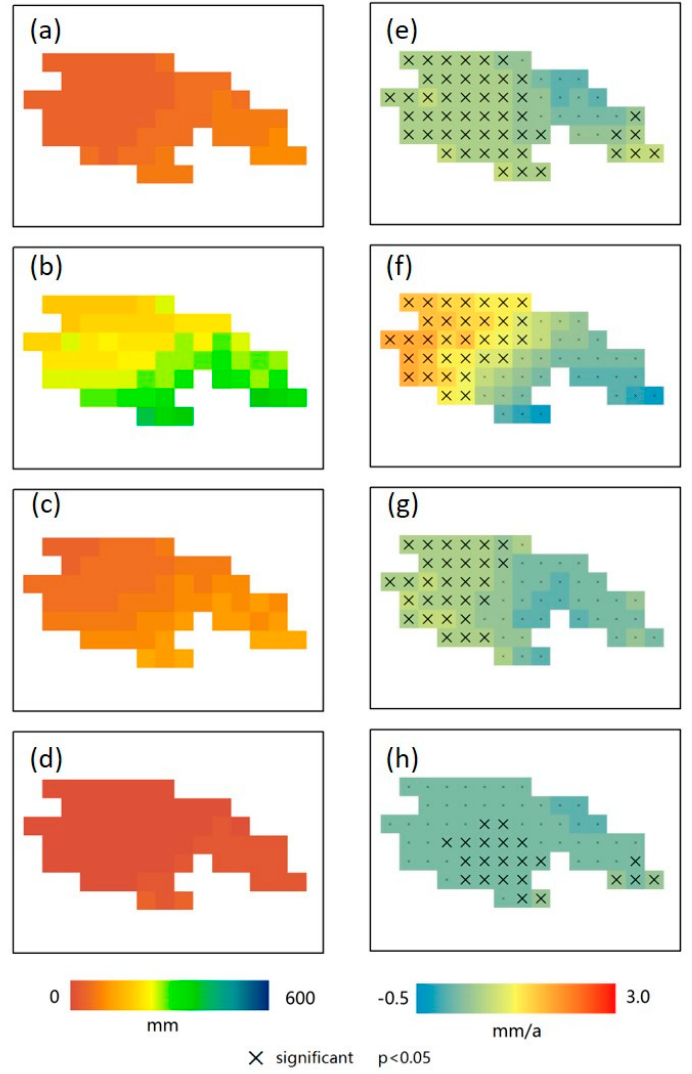
Figure 4. Spatial pattern for mean seasonal precipitation and its trend in the SRYR. ( a , e ) Spring (MAM), ( b , f ) summer (JJA), ( c , g ) autumn (SON), and ( d , h ) winter (DJF), significant area ( p < 0.05) represented by bold cross.